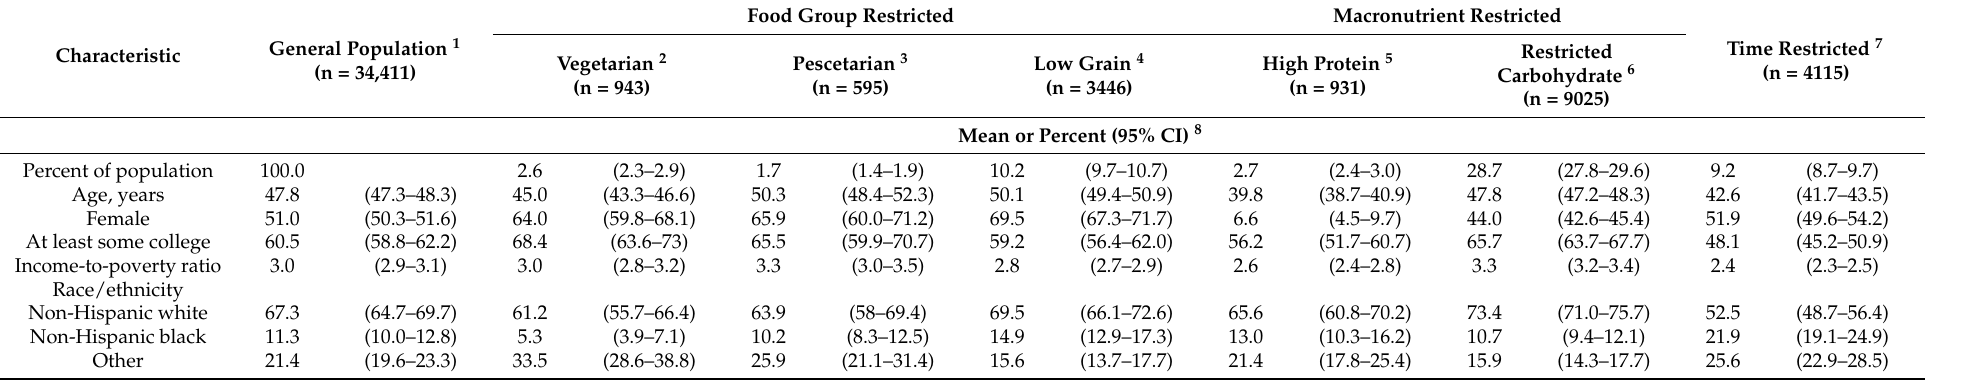
Table 1. Characteristics of study participants, 2005–2018 (n =